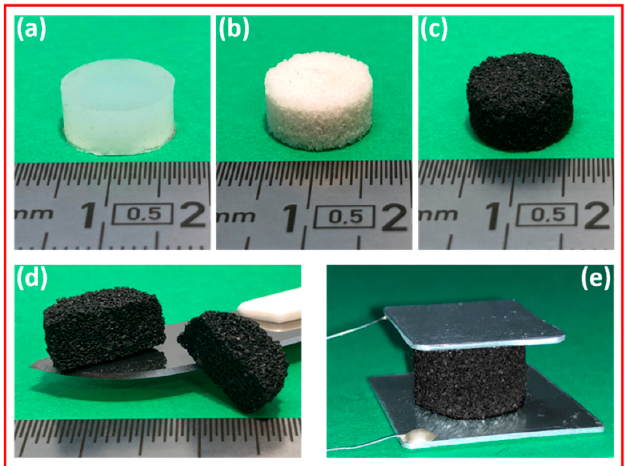
Figure 3. Ecoflex ® -based samples: bulk sample ( a ), open cell foam ( b ), GNP-loaded foam ( c,d ), and GNP-loaded foam with the conductive plates and wires ( e ).